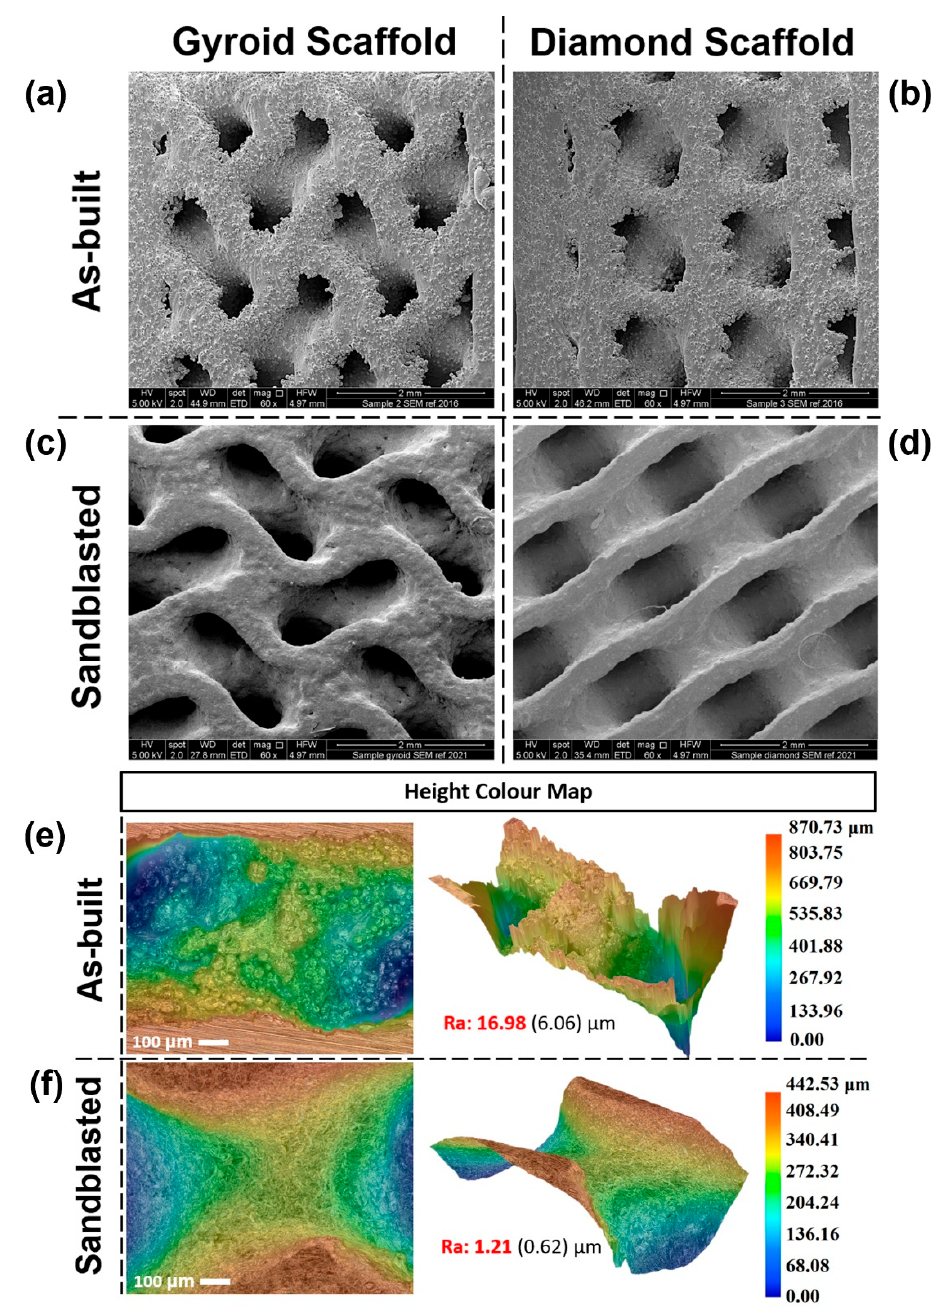
Figure 8. SEM images showing the morphology of the printed Ti6Al4V samples: ( a ) as-built gyroid, ( b ) as-built diamond, ( c ) sandblasted gyroid and ( d ) sandblasted diamond. Digital microscope images showing the morphology of the printed Ti6Al4V samples: ( e ) as-built, ( f ) sandblasted.